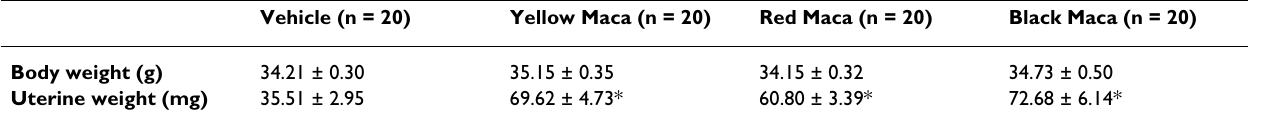
Table 1: Effect of three different varieties of Lepidium meyenii (Maca) on body and uterine weights in OVX